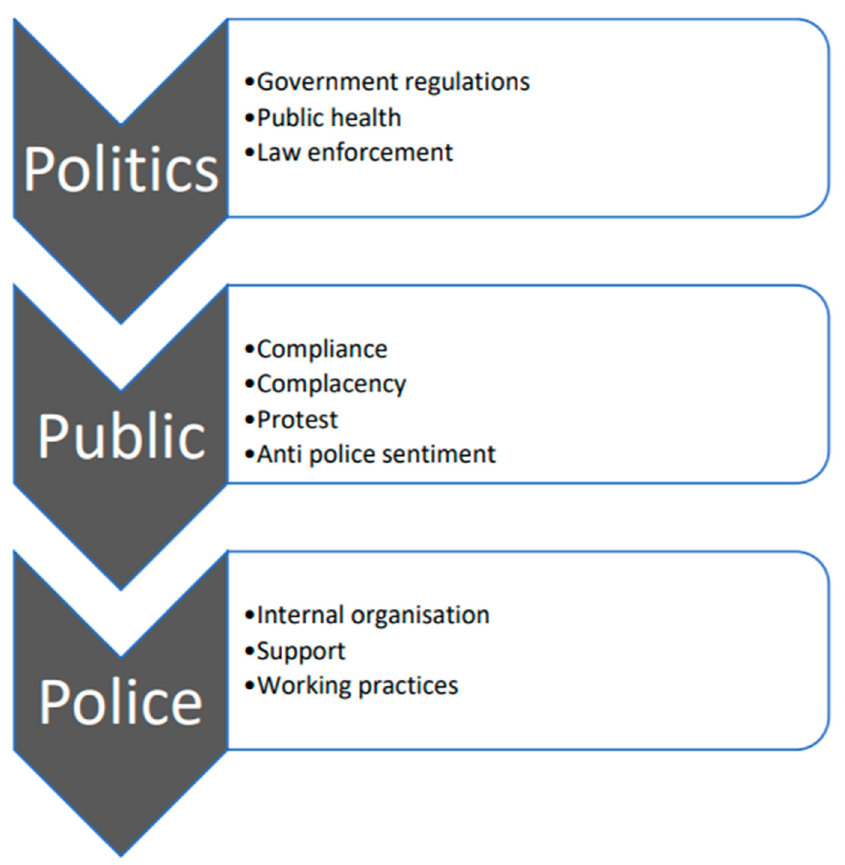
Figure 1. Central foci of concerns.